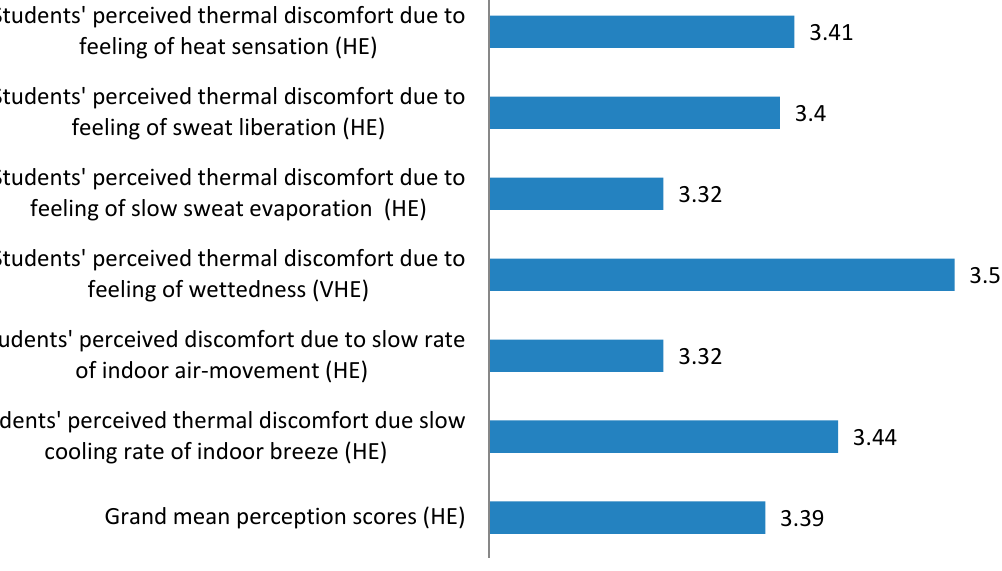
Figure 4. Students’ perceived thermal discomfort levels in LTH-3.